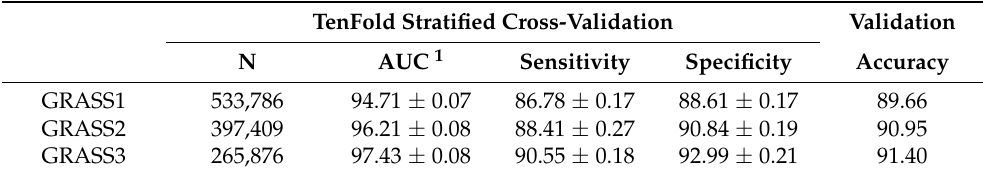
Table 2. Performances of discriminant analysis performed on the three created traits related to the grazing season. The validation set contained 721,192 records.